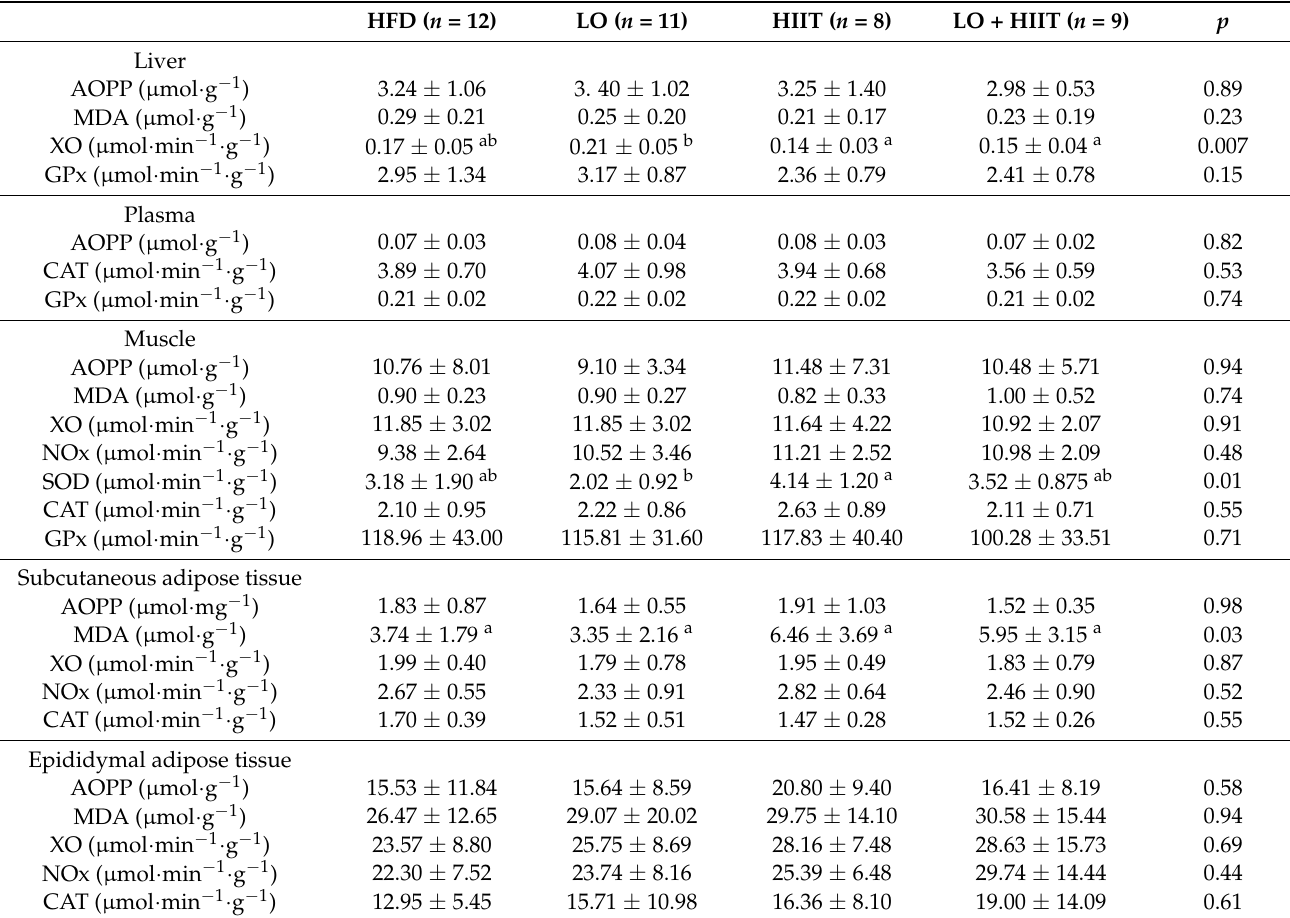
Table 2. Pro/antioxidant markers in the HFD ( n = 12), LO ( n = 11), HIIT ( n = 8), and HIIT + LO ( n = 9) groups at the end of phase 2 (training and/or LO supplementation for 12 weeks). a,b Newman Keuls Post hoc test: means with the same letter indicate no significant difference. Any difference between two means carrying